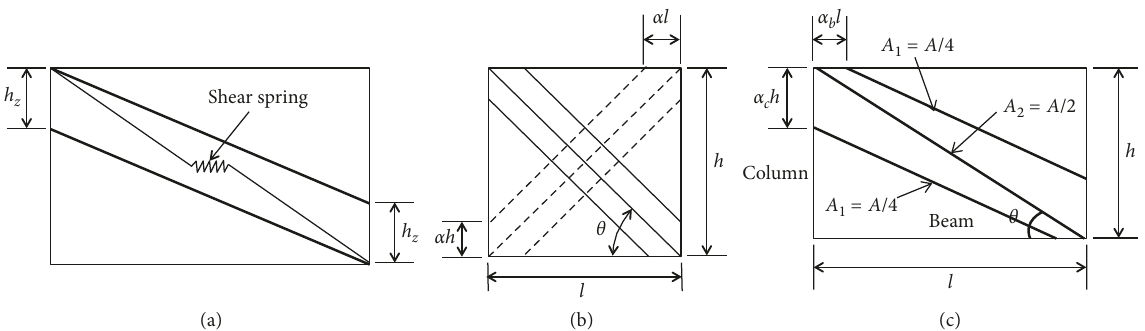
Figure 5: Multiple-strut macrofinite element models: (a) double-strut model with shear spring [30]; (b) six-strut model [31]; (c) three-strut model